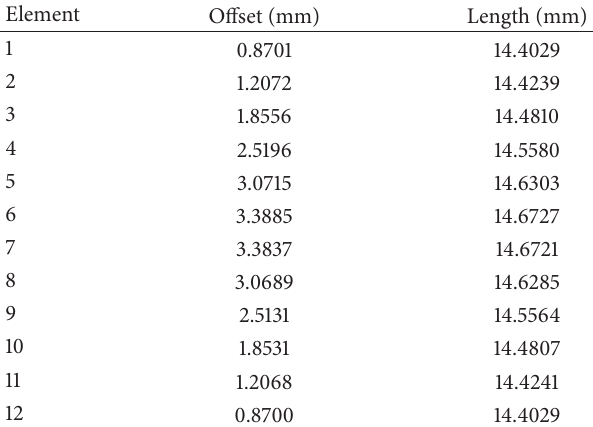
Table 1: Parameters of the resonant array.